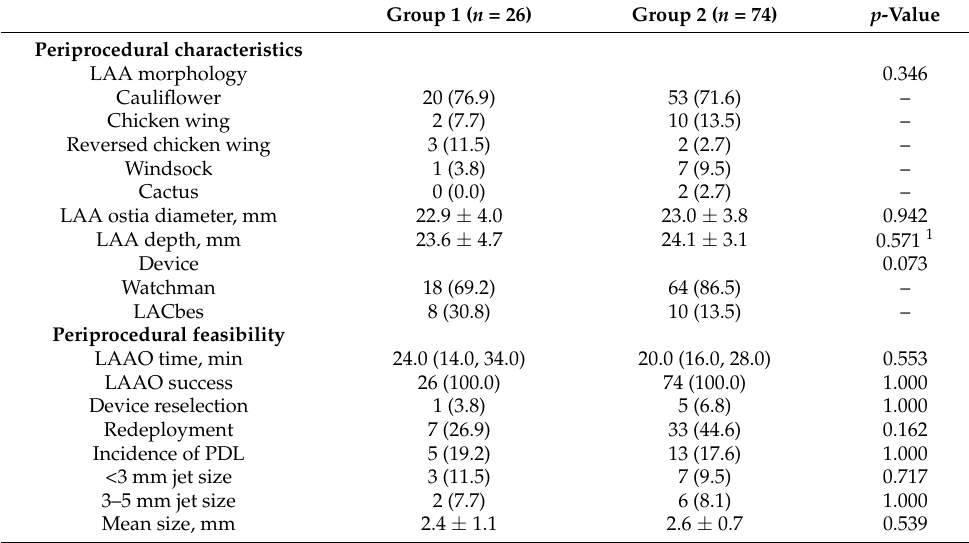
Table 2. Periprocedural characteristics and